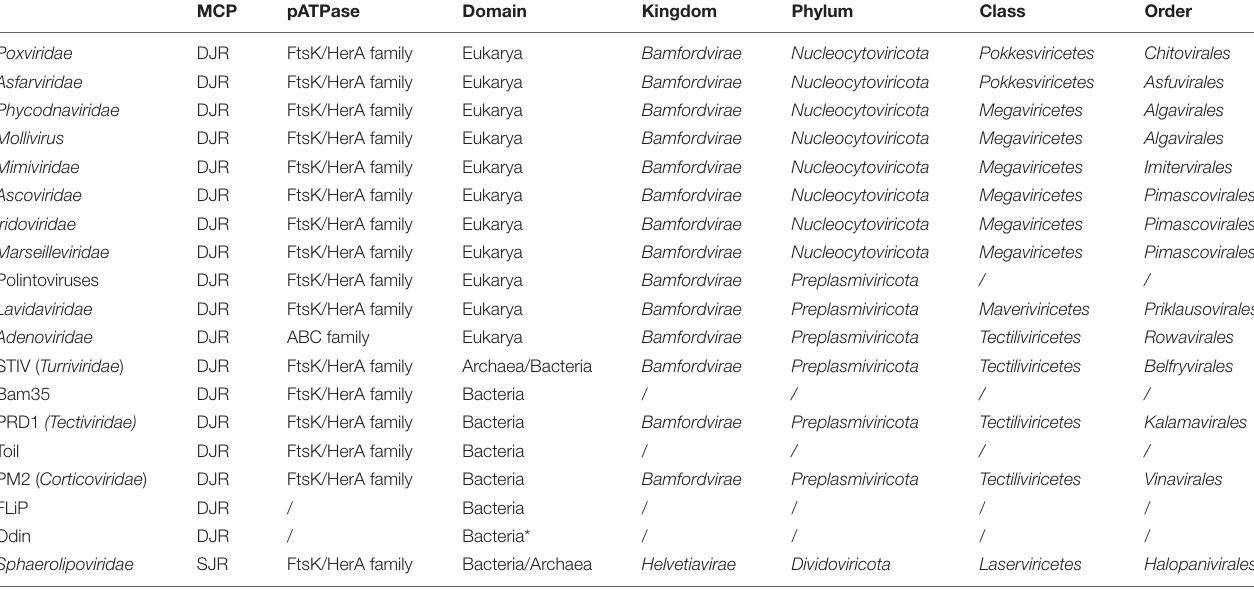
TABLE 1 | Viruses of the realm Varidnaviria